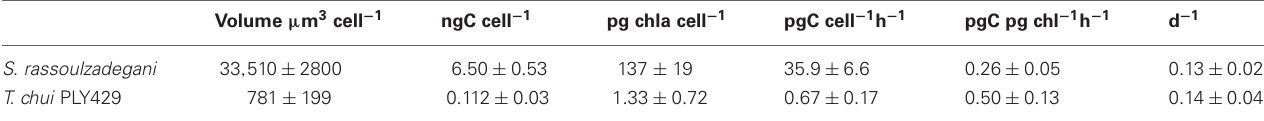
Table 3 | Volume, carbon and pigment contents, and photosynthetic incorporation of 14 C into the ciliate Strombidium rassoulzadegani and its food, Tetraselmis chui PLY429 ( ± standard deviation, where